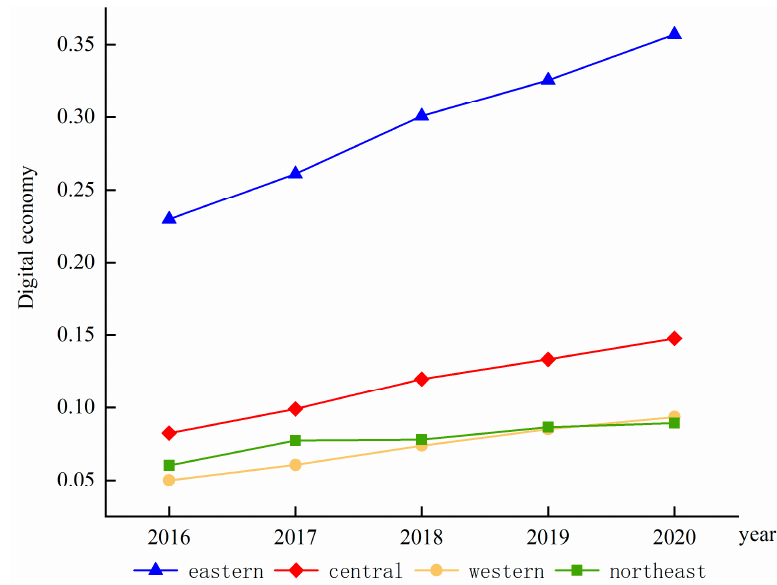
Figure 1. The development level trend of the digital economy in four